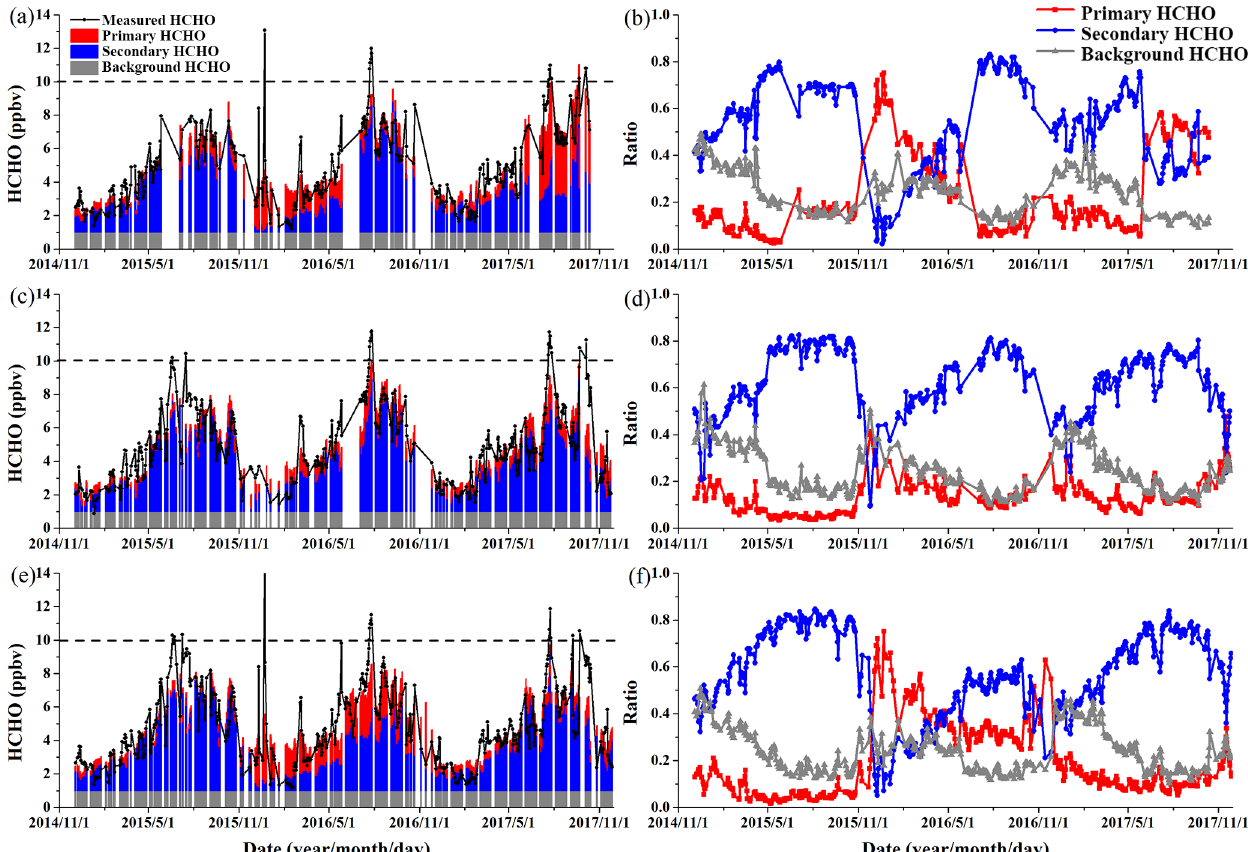
Figure 8. The time series of absolute ( a, c, e ) and relative ( b, d, f ) contributions of primary sources, secondary sources, and background sources to the HCHO concentration from December 2014 to November 2017 at the XS (a, b) , CXT (c, d) , and FDCH (e, f) sites in Hangzhou. Black dashed lines represent the threshold value for HCHO